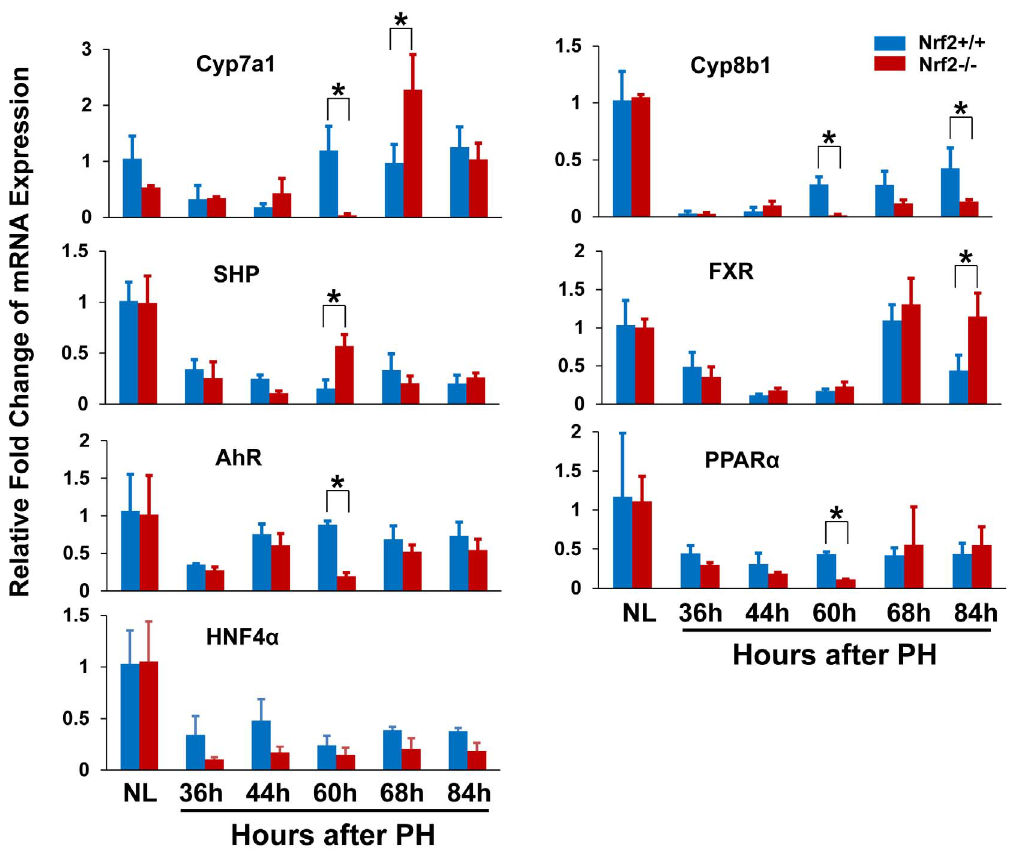
Figure 5. The mRNA expression of a group of genes associated with liver functions in regenerating livers of Nrf2 + / + and Nrf2 2 / 2 mice. Total RNA was prepared from the livers at the indicated time points after partial hepatectomy (PH). Hepatic expression levels of the genes indicated were measured by qRT-PCR and are expressed as the means of fold changes relative to the mRNA level in normal livers in Nrf2 + / + mice 6 SD (n=3 mice/time point/genotype; *, p , 0.05 between Nrf2 + / + and Nrf2 2 / 2 mice). NL, normal liver.